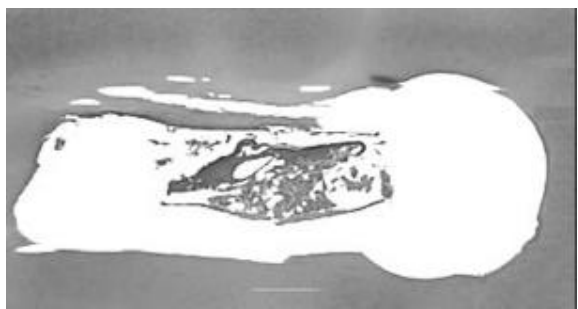
FIGURE 3- Slide showing a root canal from group 3, with the presence of